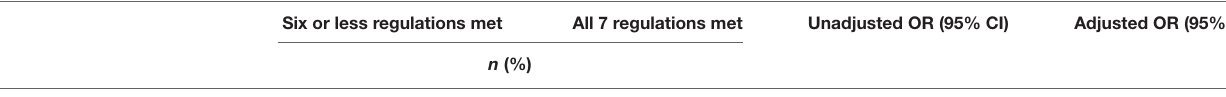
TABLE 6 | Regression models for updated regulation